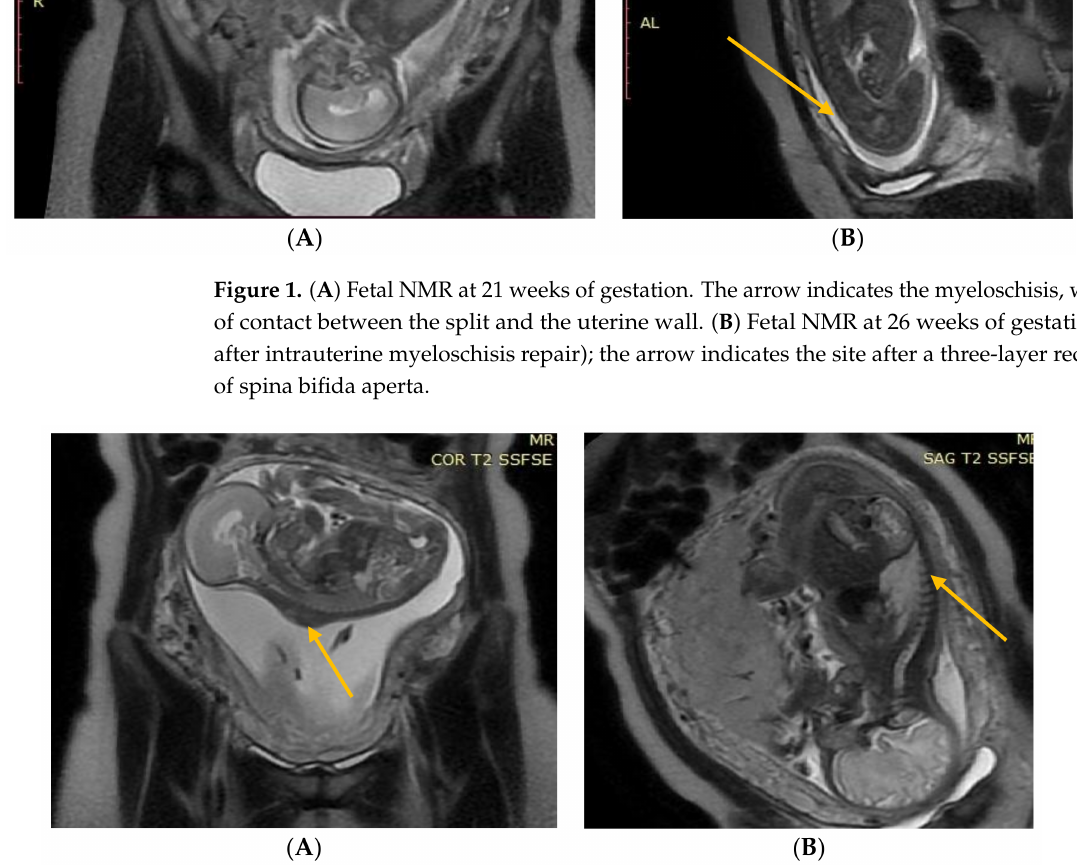
Figure 2. ( A ) Fetal NMR at 22 weeks of gestation. The arrow indicates the myelomeningocele. ( B ) Fetal NMR at 26 weeks of gestation (4 weeks after intrauterine myelomeningocele repair); the arrow indicates the site after a three-layer reconstruction of spina bifida aperta, with the area of contact between the repair site and the uterine